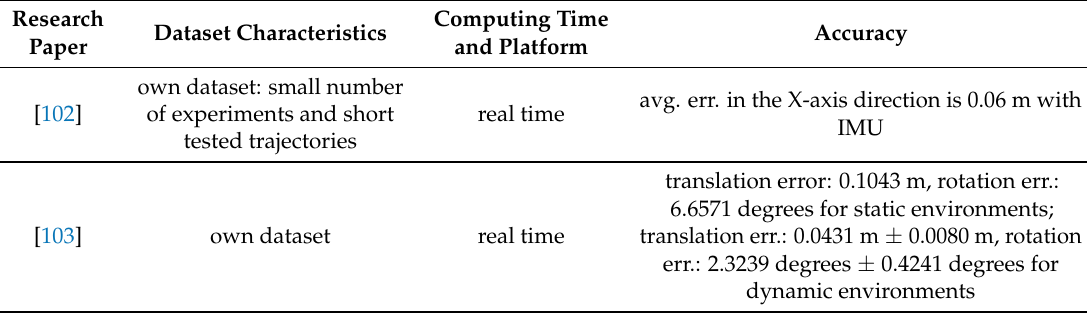
Table 13. Characteristics of indoor localization solutions with real image/feature databases, 3D mobile cameras + other sensors, and traditional image